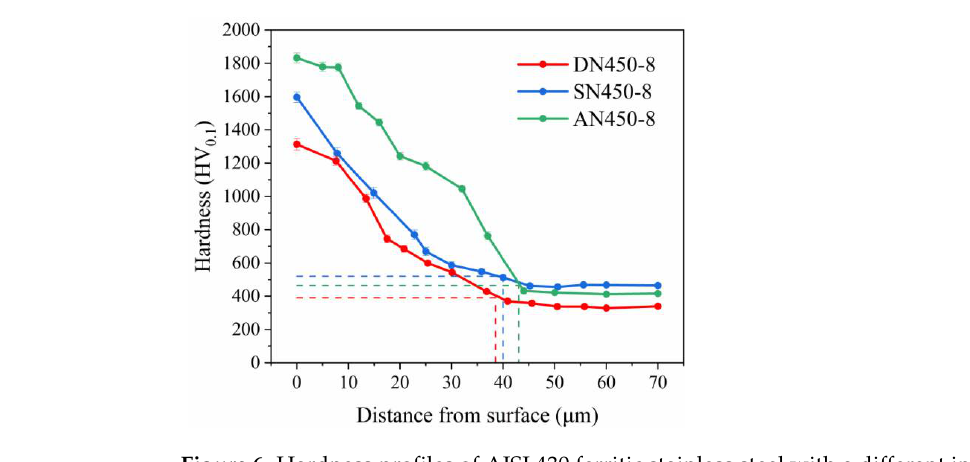
Figure 6. Hardness profiles of AISI 430 ferritic stainless steel with a different initial microstructure after low-temperature plasma nitriding.